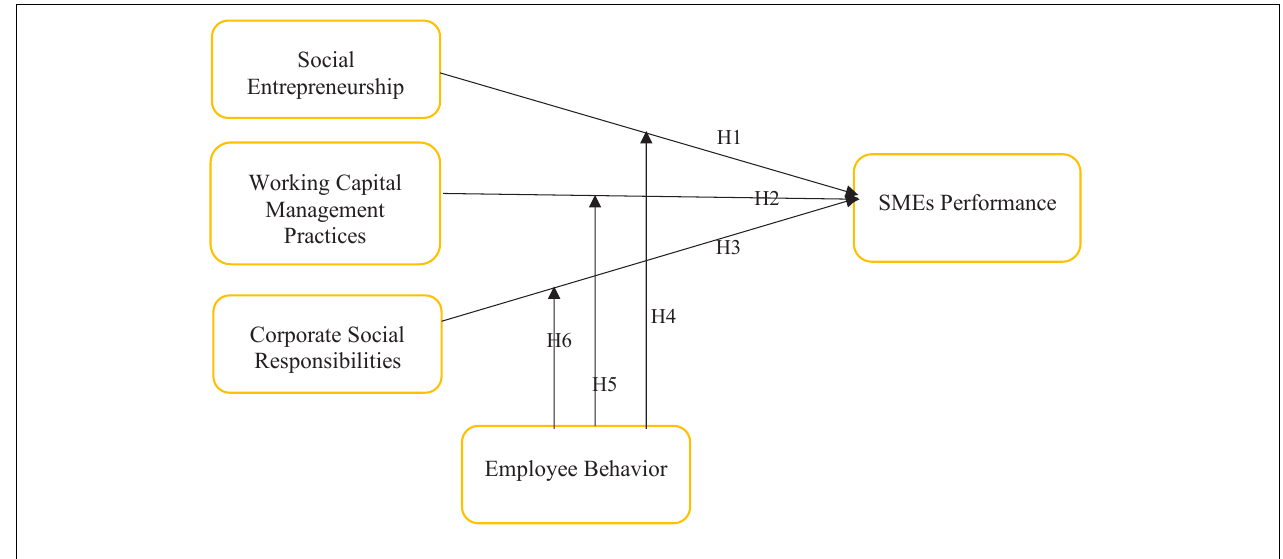
FIGURE 2 | Research